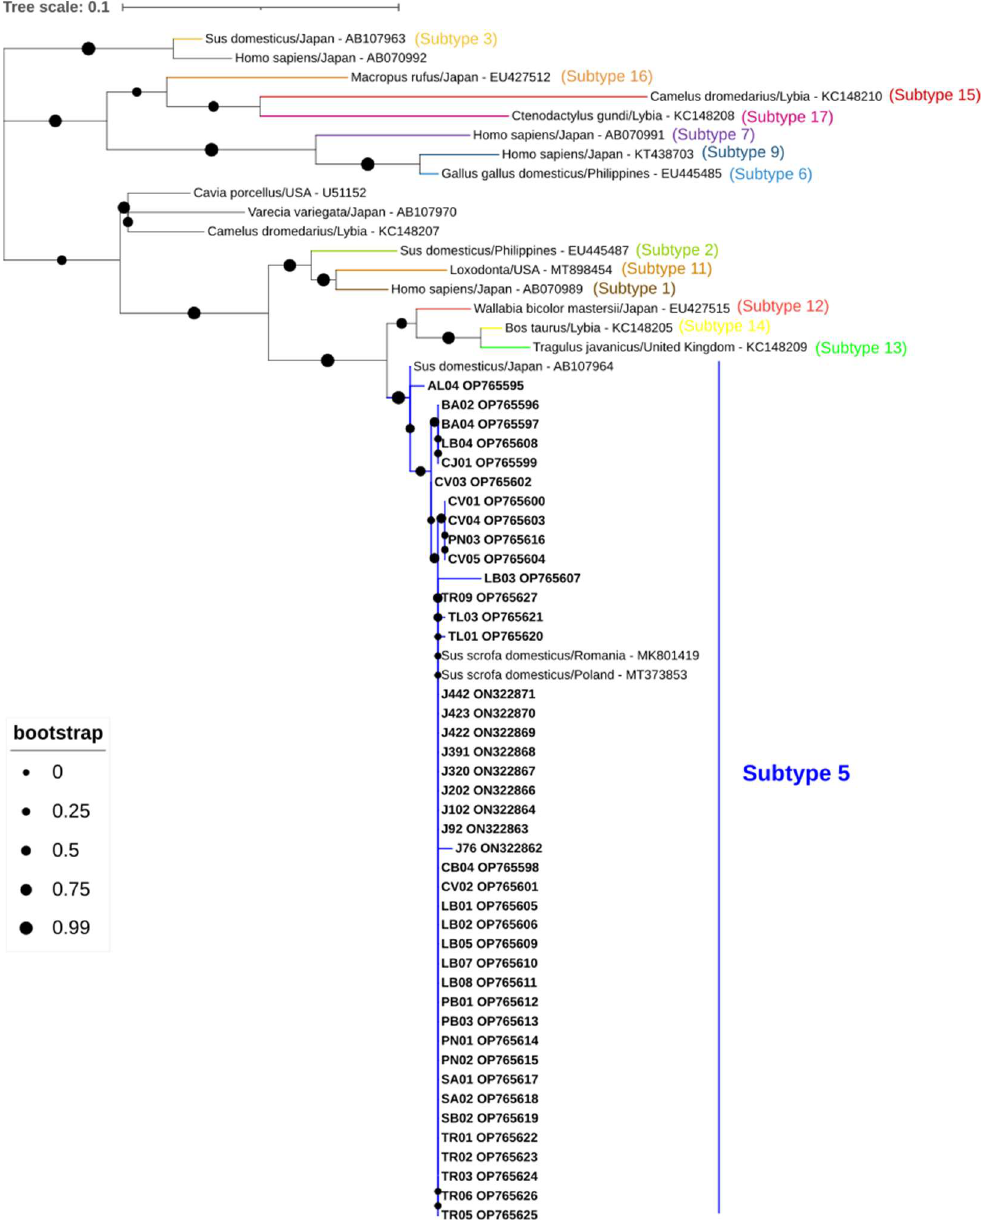
Figure 4. Phylogenetic analysis of Blastocystis found in wild boars. Tree inferred using the MEGA X maximum likelihood method (Tamura 3-parameter model) and the Interactive Tree of Life (iTOL) based on 62 nucleotide Blastocystis sequences at the ssu rRNA marker, including sequences found in this study ( Blastocystis subtype 5, plus its accession numbers, is in bold) and 20 strains of different subtypes obtained from GenBank (subtype 1-17) (no bold or shading and identified with the accession number, host and country of origin).